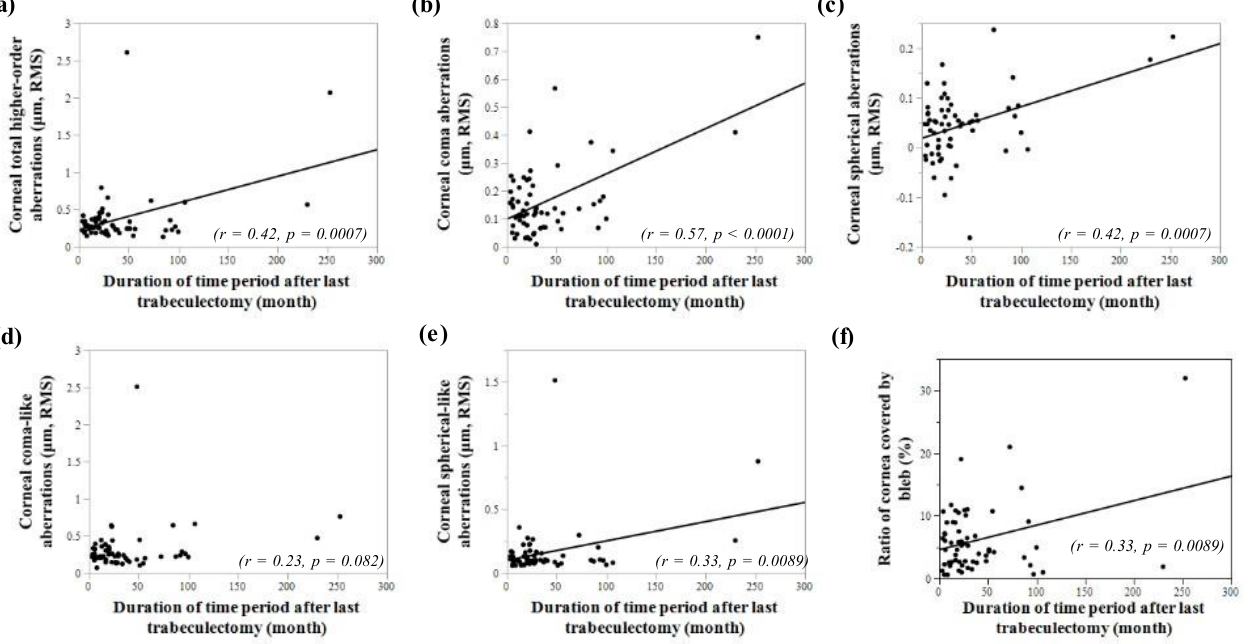
Figure 3. A linear regression comparison of the duration of time period after last TLE and corneal higher-order aberrations (HOAs). ( a ) There is a positive correlation between duration of time period after last TLE and corneal total HOAs (r = 0.42; p = 0.0007). ( b ) There is a positive correlation between duration of time period after last TLE and corneal coma aberrations (r = 0.57; p < 0.0001). ( c ) There is a positive correlation between duration of time period after the last TLE and corneal spherical aberrations (r = 0.42; p = 0.0007). ( d ) Corneal coma-like aberrations showed no correlation between duration of time period after the last TLE (r = 0.23; p = 0.0082). ( e ) There is a positive correlation between duration of time period after the last TLE and corneal spherical-like aberrations (r = 0.33; p = 0.0089). ( f ) There is a positive correlation between duration of time period after last TLE and the ratio of cornea covered by bleb (r = 0.33; p =